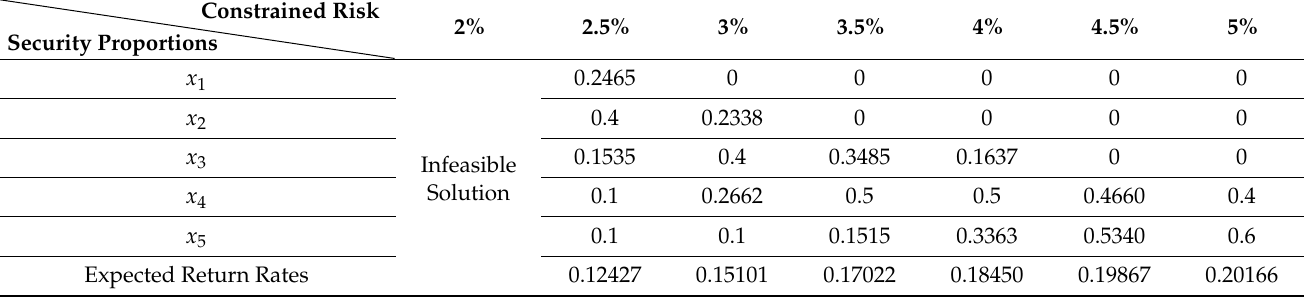
Table 5. The dimension with t = 3 and s = 2 with a guaranteed return rate (cid:101) p 2 in the proposed